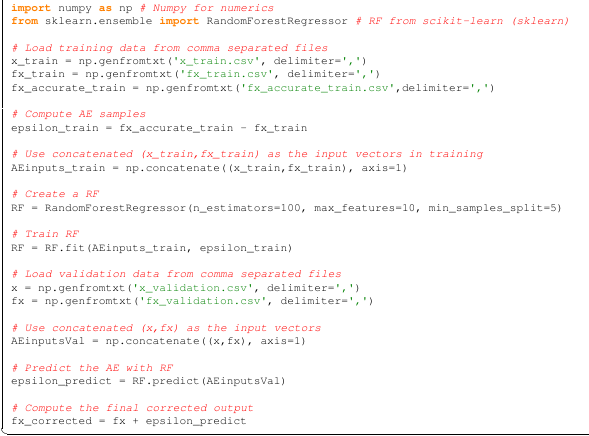
Fig.2. AnexamplecodelistingfortrainingandevaluatinganRF-modelinscikit-learn. Fig. 2. An example code listing for training and evaluating an RF model in